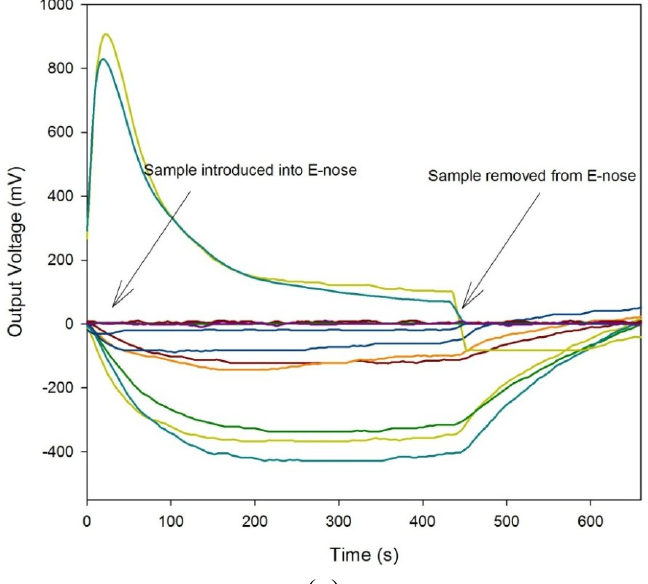
Figure 2. Typical output of the ( a ) Electronic Nose and ( b ) Owlstone FAIMS